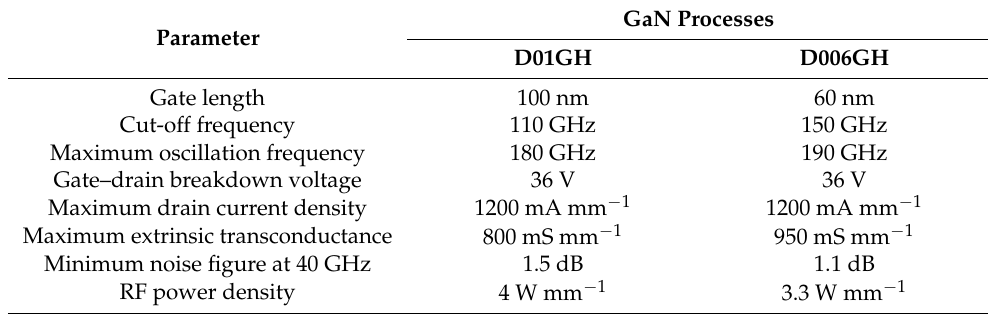
Table 8. Main features of two commercial GaN-on-Si HEMT technologies with different gate lengths. Reproduced with permission from ref. [224]. Copyright 2021 MDPI.